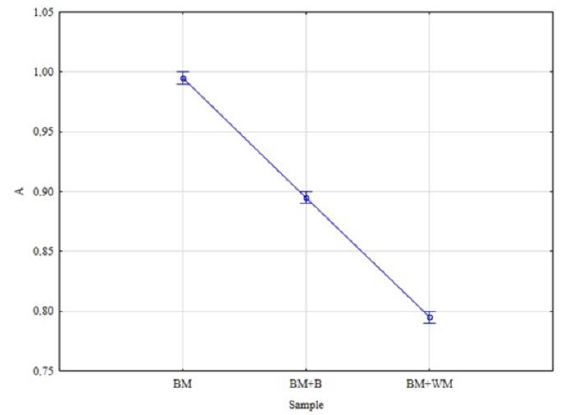
Figure 8. Mean contents of ash (A) in BSG.